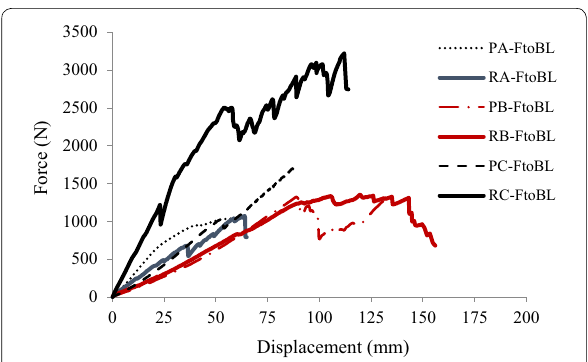
Fig. 10 The force–displacement diagrams of the chairs under FtoBL